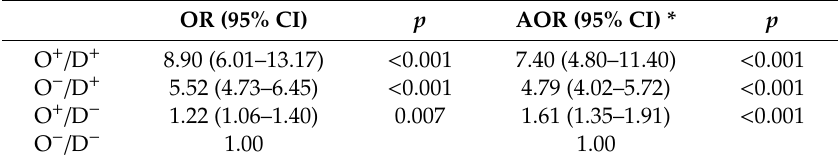
Table 4. Logistic regression to compare the risk for fair and poor HRQoL between disease